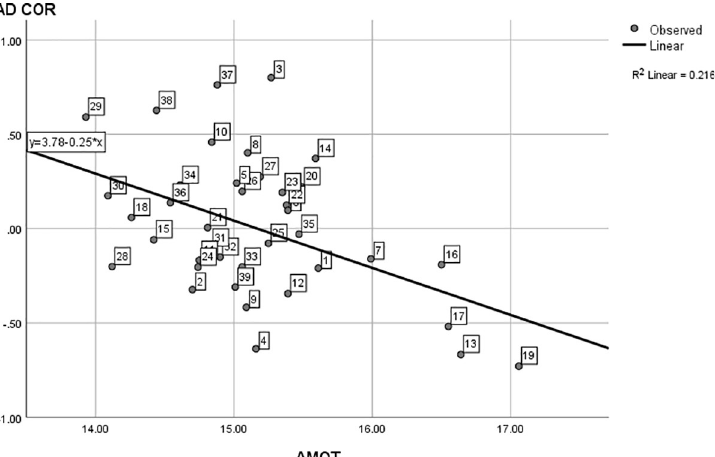
Fig 3. The linear regression of interest diversity on autonomous motivation. Interest Diversity is measured using AD COR (based on D COR z–scores), with AMOT = autonomous motivation. The data points (dotted study programs) are labeled analogous to Table 1.